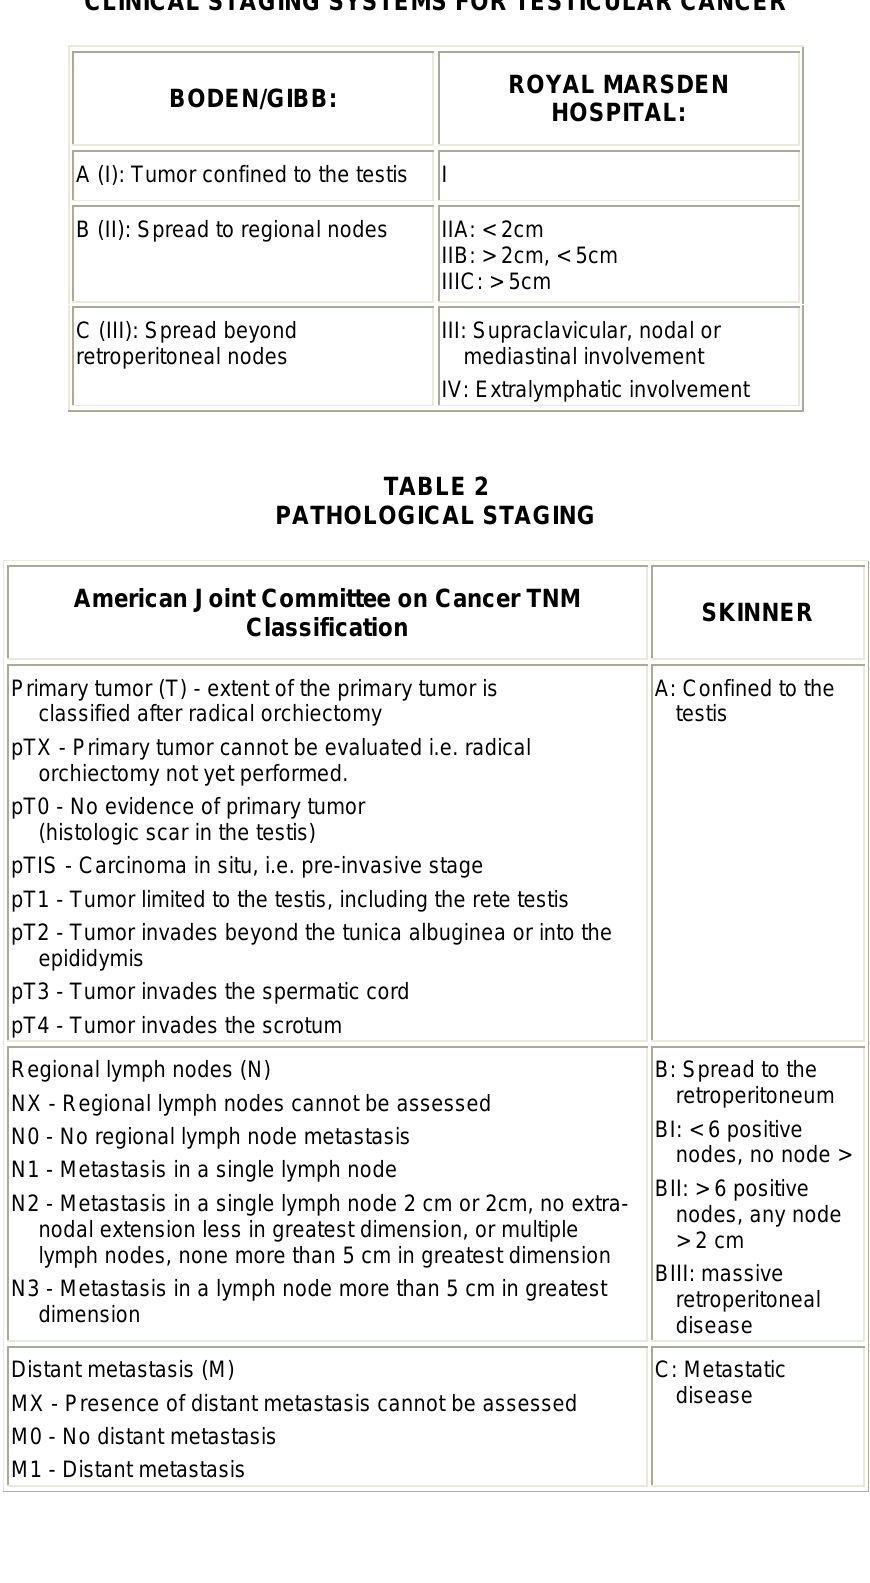
CLINICAL STAGING SYSTEMS FOR TESTICULAR CANCER